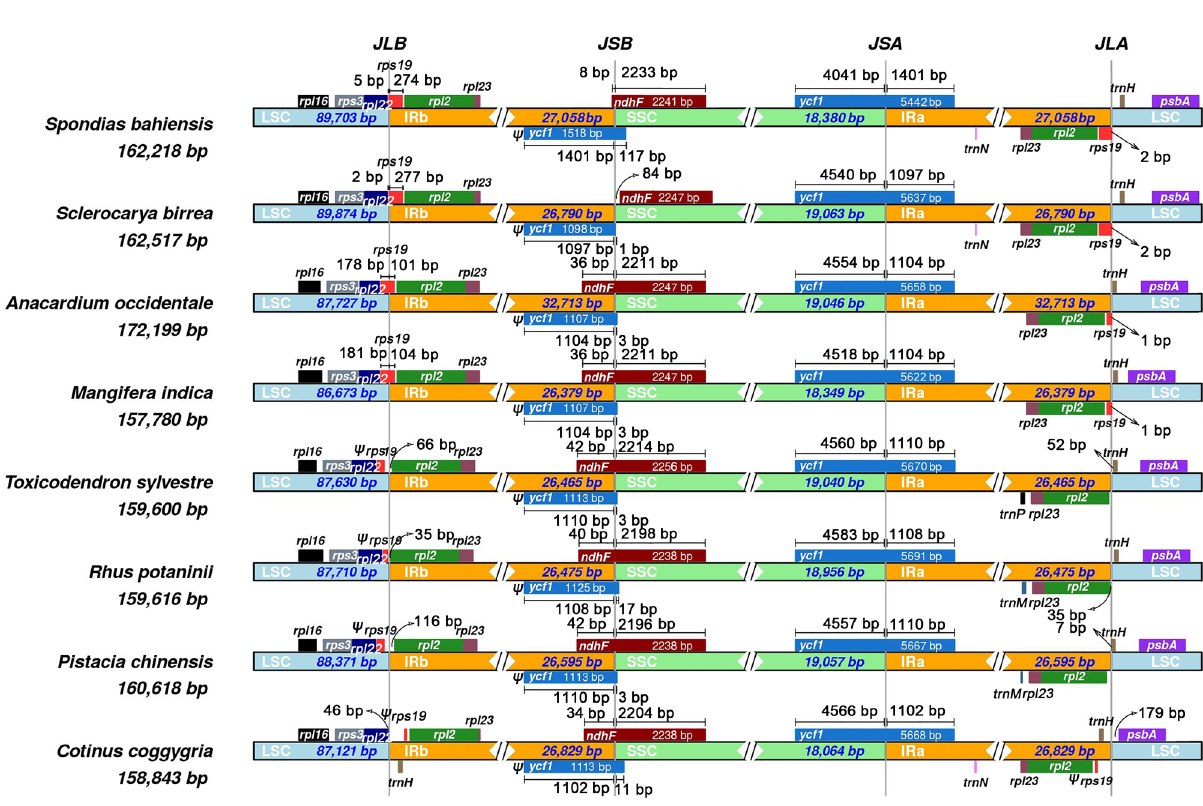
Figure 2 – Comparison of the borders among LSC, SSC, and IR regions of eight analyzed species. The genes around the borders are shown above or below the mainline. The JLB, JSB, JSA, and JLA represent junction sites of LSC/IRb, IRb/SSC, SSC/IRa, and IRa/LSC,